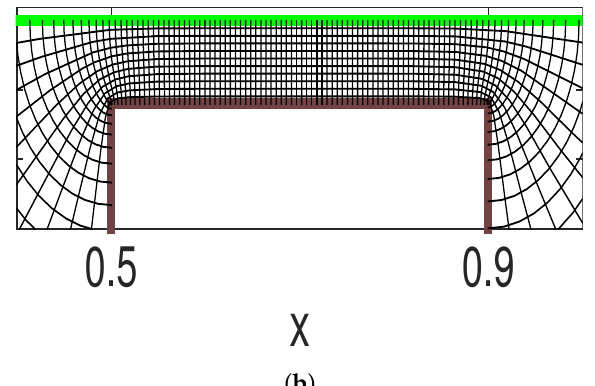
Figure 2. ( a ) At the top: Three cavities with the orthogonal ξζ level curves from the conformal mapping x + iz = f ( ξ + i ζ ) . The Schwarz-Christoffel Toolbox (SCT) used 300 points for ξ , and 10 depth levels for ζ . ( b ) At the bottom: Detail of the level curves over the barrier, displaying the high degree of distortion from a uniform grid in one domain when mapped to the other.